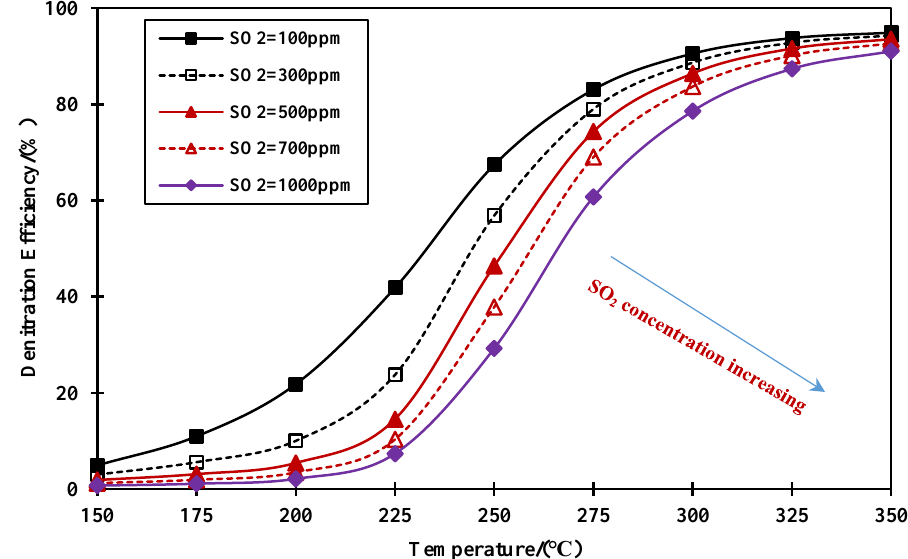
Figure 10. The relationship between the denitration efficiency and the SO 2 concentration at different temperatures (O 2 : 16%, H 2 O: 3%).